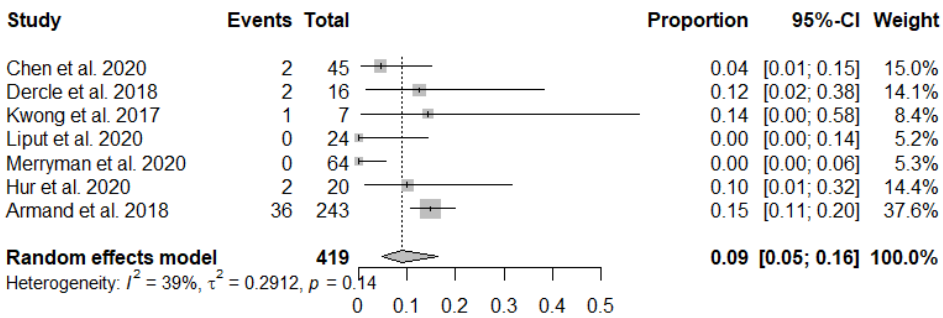
Figure 6. Forest plots show the pooled incidence of pseudoprogression among patients treated